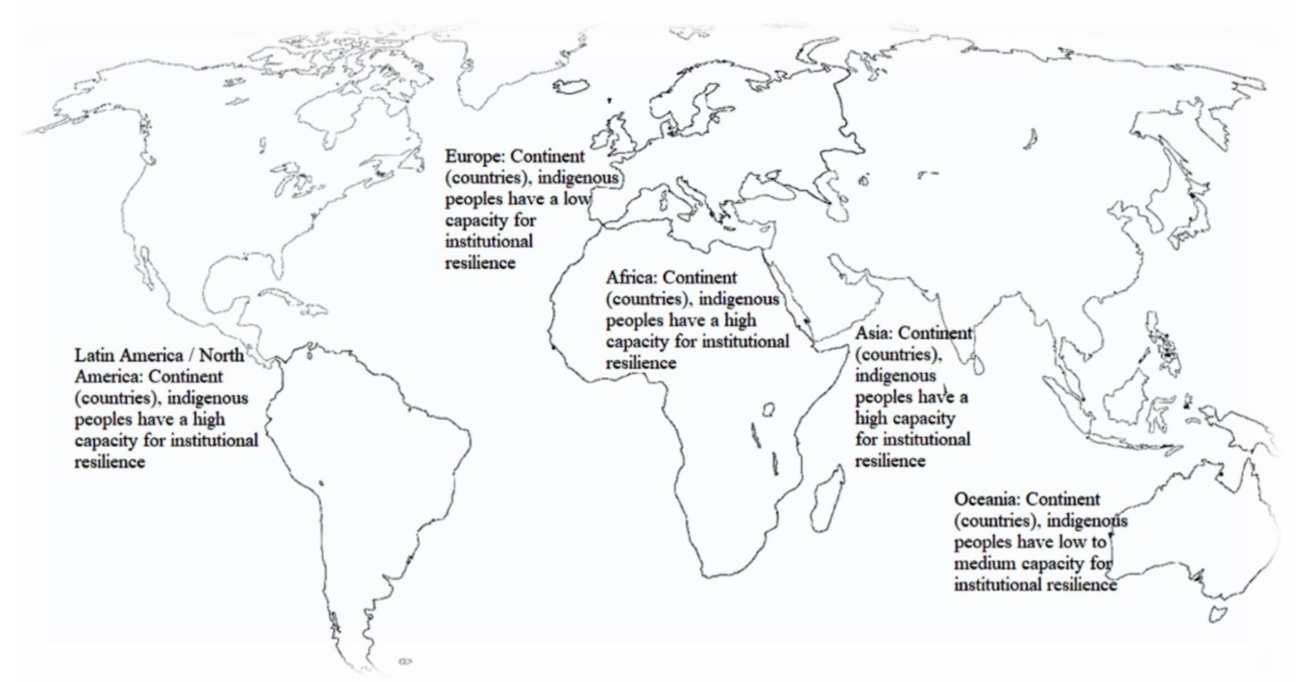
Figure 3. Institutional resilience capacity global. Source: own elaboration based on the information of